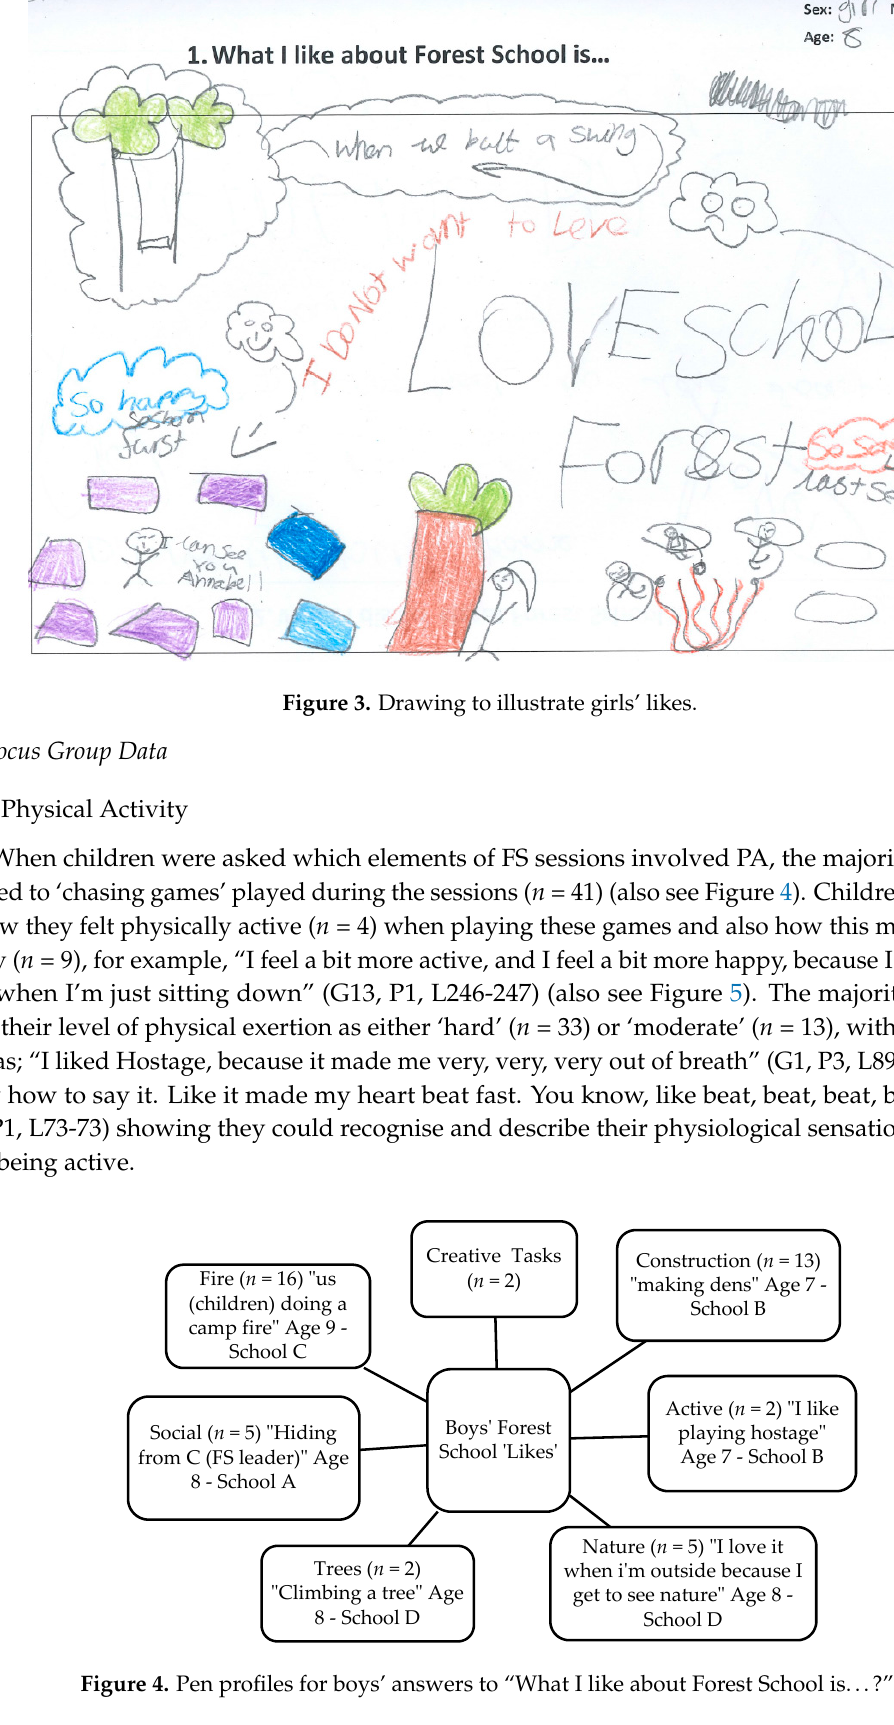
Figure 2. Drawing to illustrate boys’ likes.